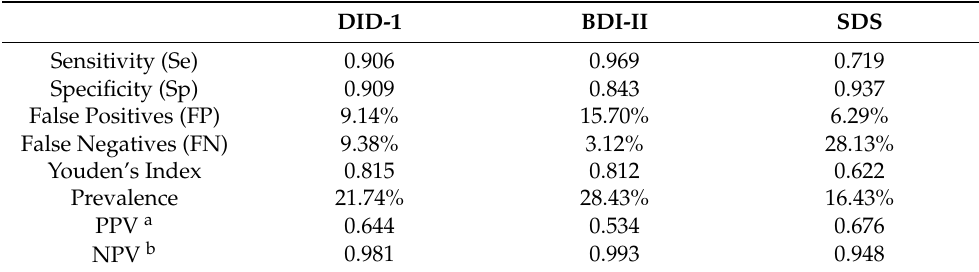
Table 5. Parameters of validity of depression